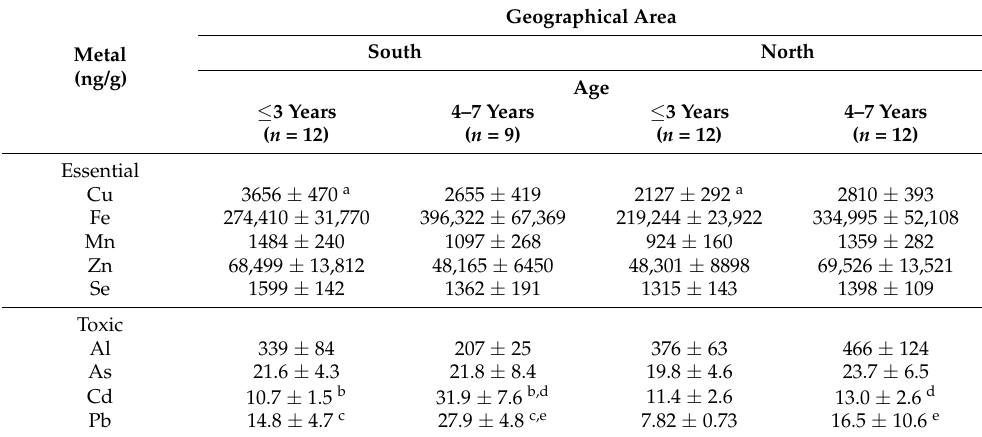
Table 4. The levels of essential and non-essential metals (mean ± SEM) in ovarian tissues of selected age groups of free-ranging